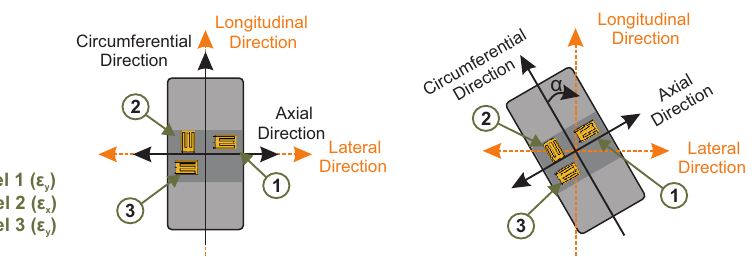
Figure 7. Main measuring direction of the strain sensors.